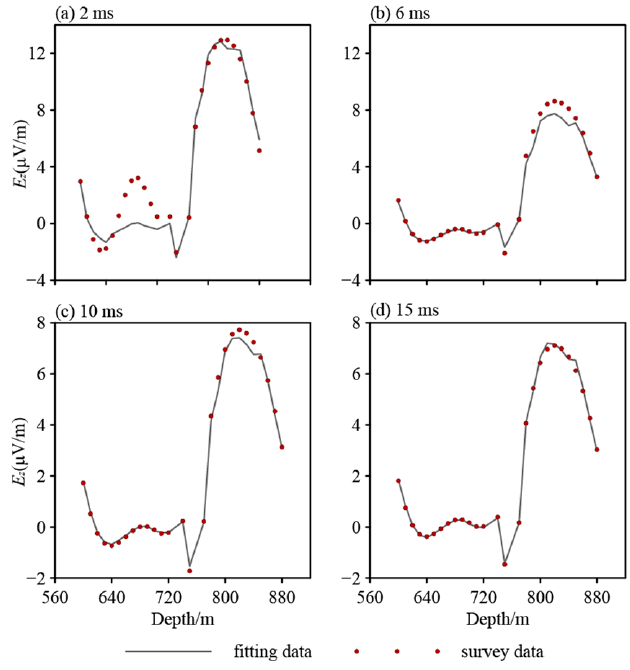
Figure 14. Surface data fitting for the field data inversion.